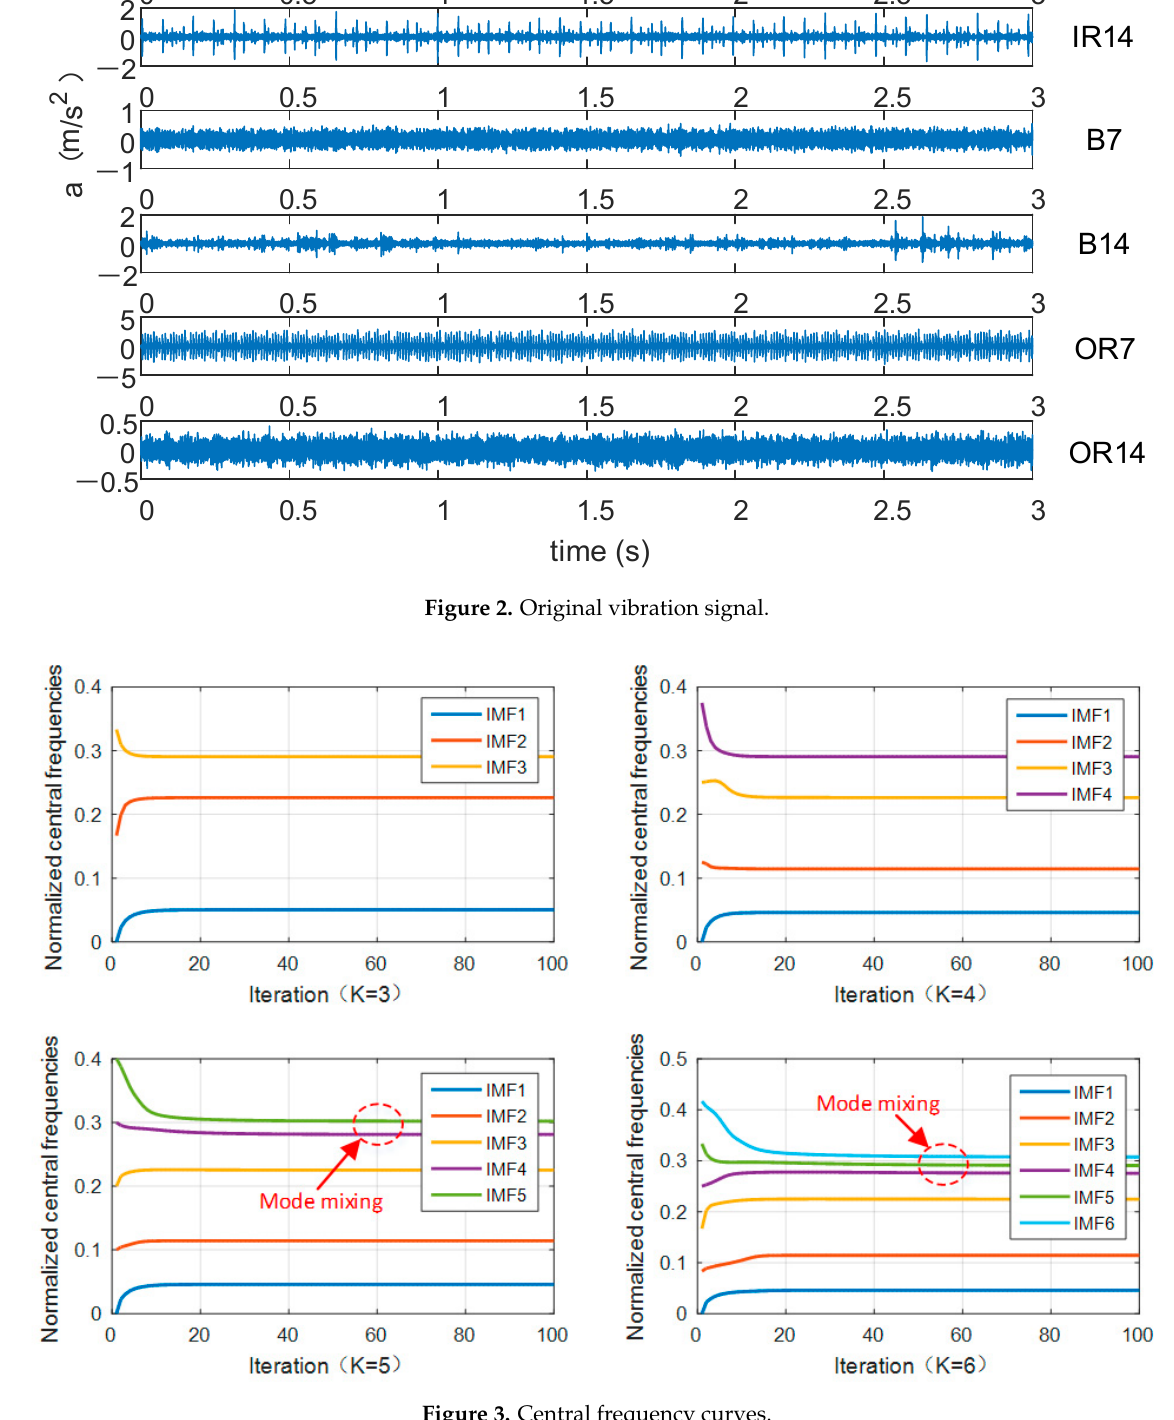
Figure 3. Central frequency curves.